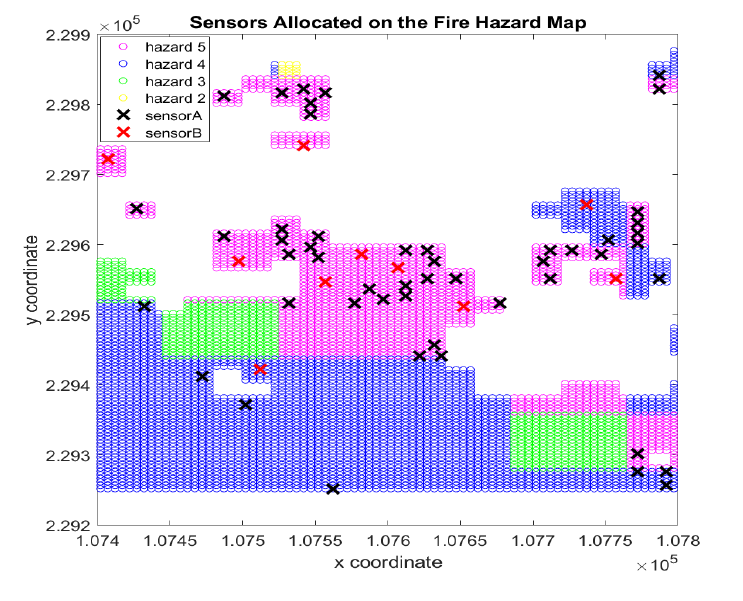
Figure 8. Optimum solution to spread sensor on Region